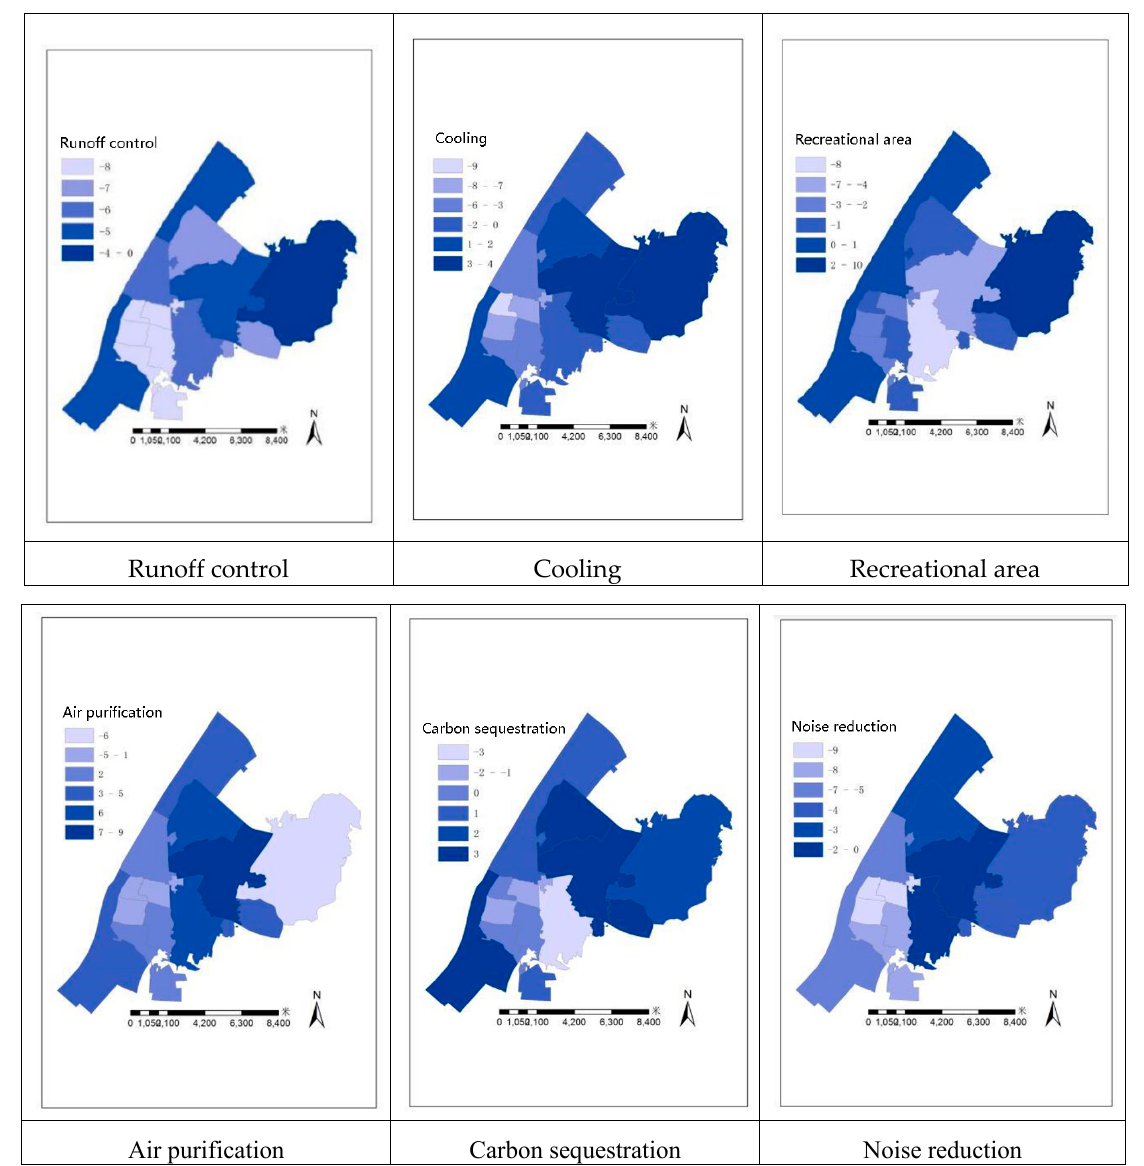
Figure 5. Net ecosystem services results.